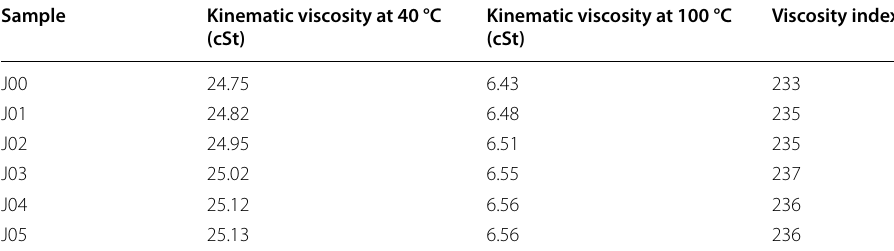
Table 4 Kinematic viscosity and viscosity index of samples